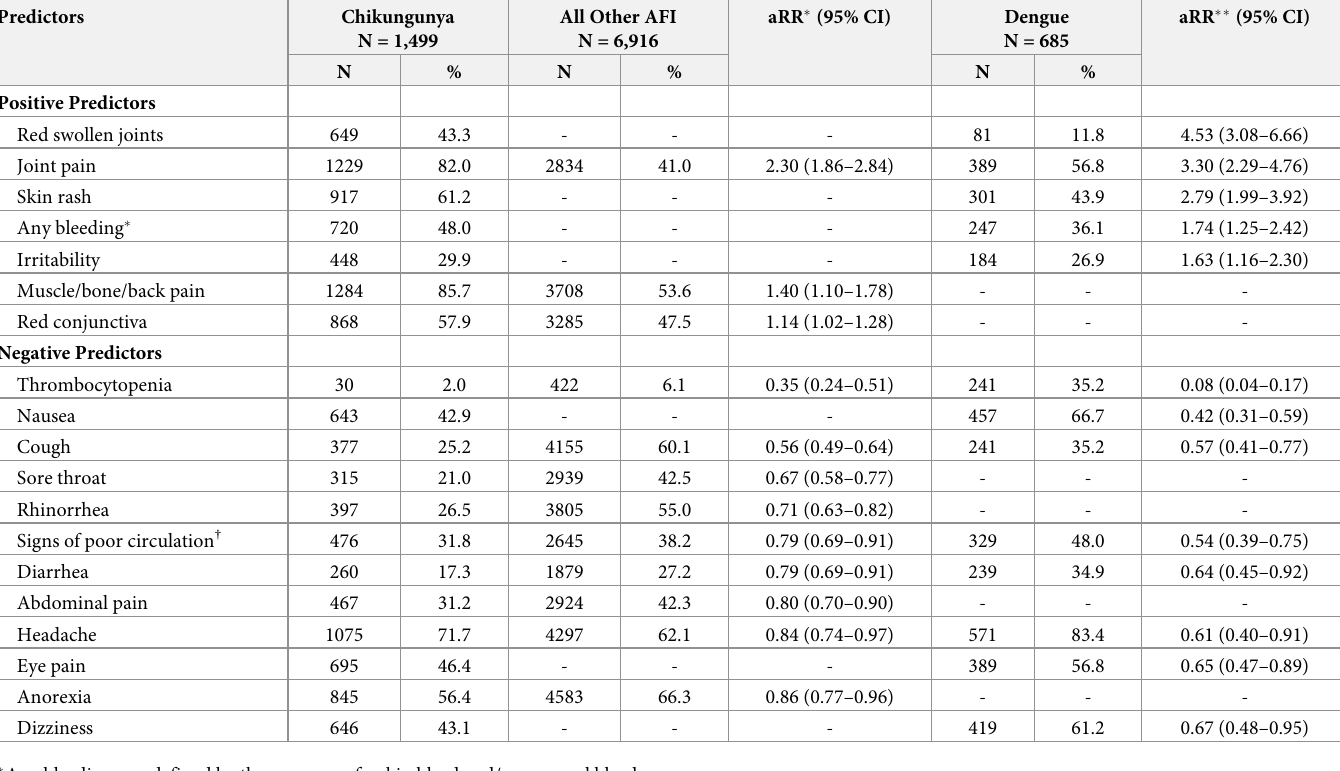
Table 2. Predictors of laboratory-confirmed chikungunya versus all other acute febrile illnesses or laboratory-confirmed dengue for all ages regardless of the timing of presentation, Acute Febrile Illness Study, May 7, 2012–May 6, 2015, Puerto Rico.